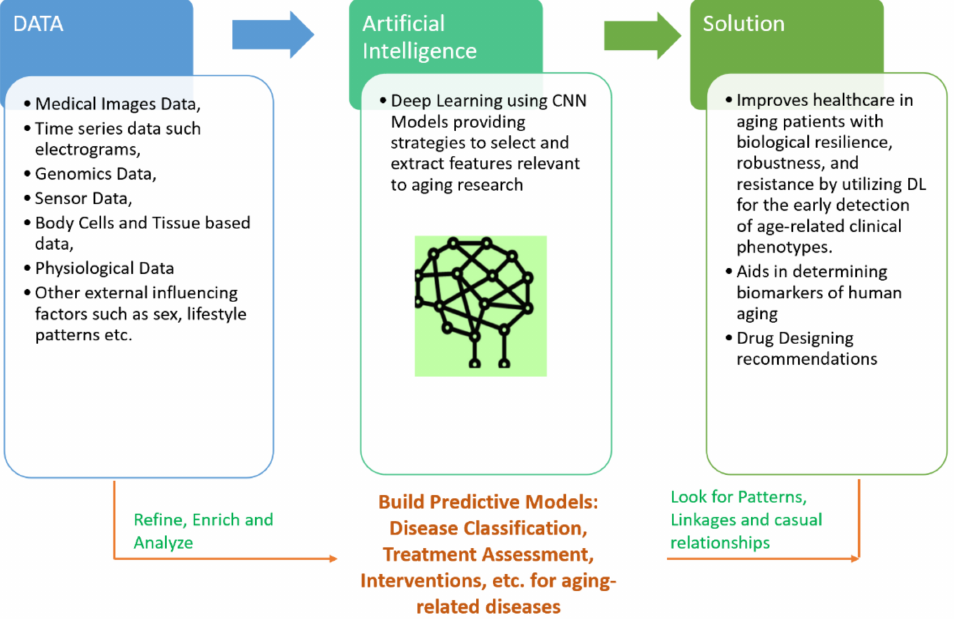
Figure 1. A generalized conceptual framework for applying DL to aging-related